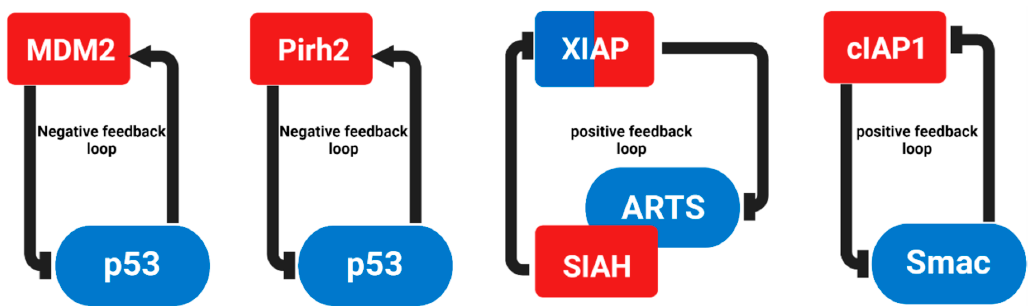
Figure 2. Each of these feedback loops consists of proteins whose levels and function are influenced by the activation or inhibition of their E3 ligase. Arrows indicate stimulatory interactions, whereas horizontal bars denote inhibitory influ- ences.